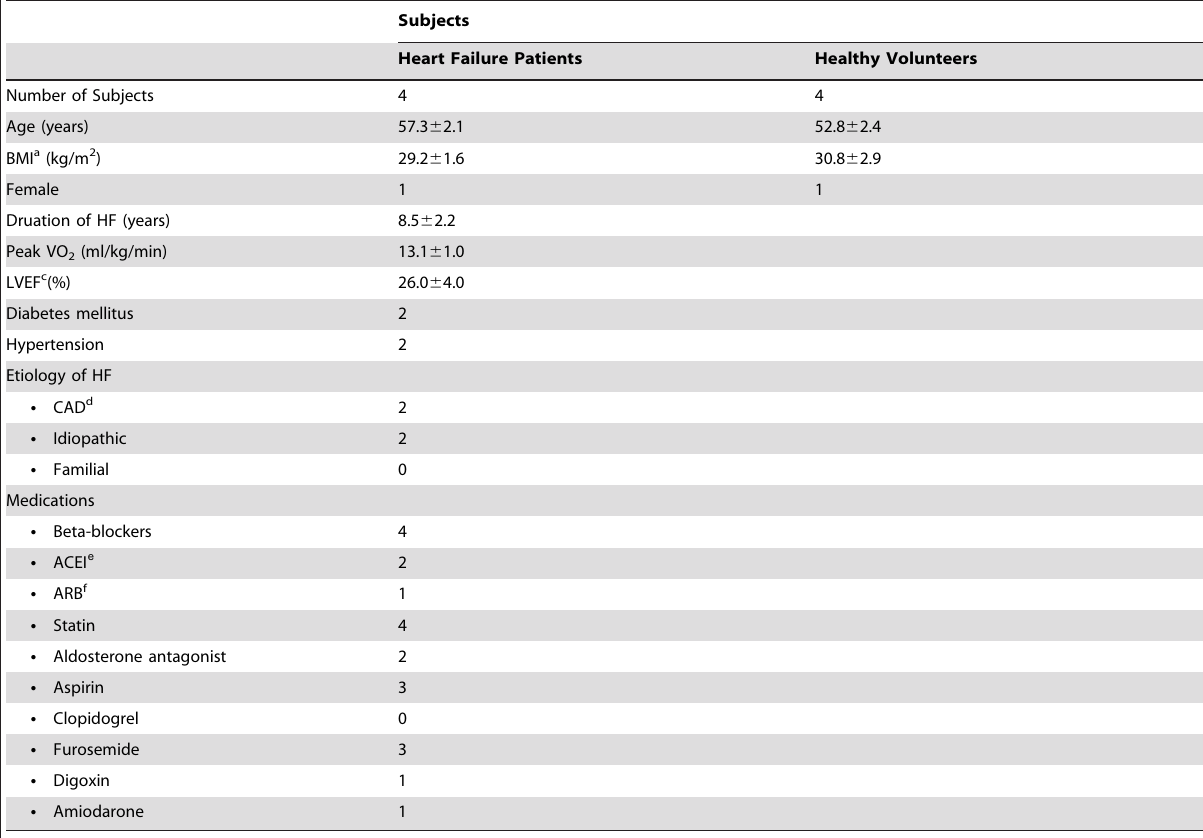
Table 1. Study Population